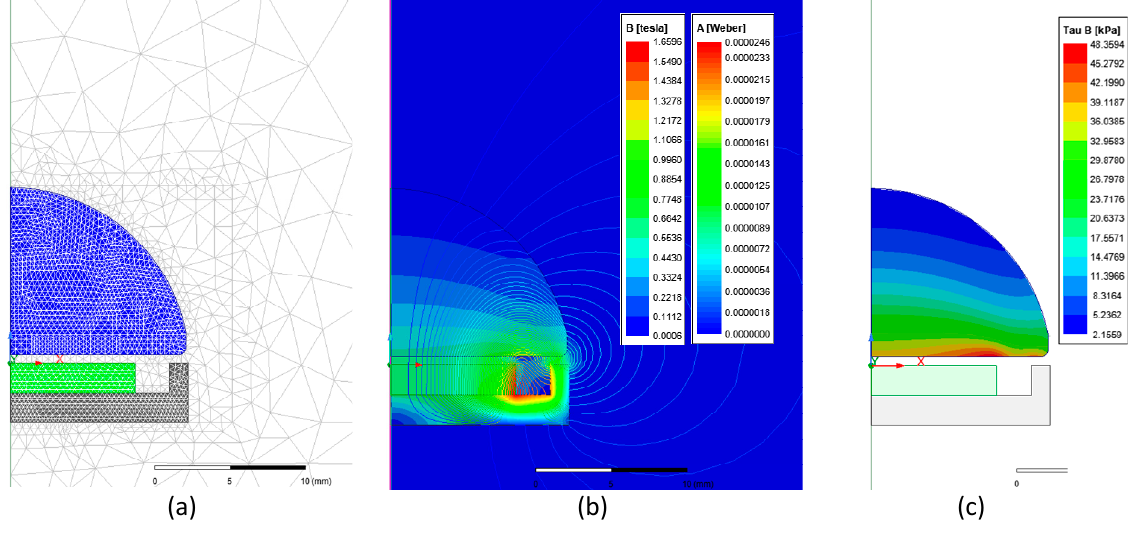
Figure 4. Simulation environment: ( a ) exemplary FE mesh; ( b ) magnetic flux and magnetic flux density plots; ( c ) determined stress distribution in MRF.